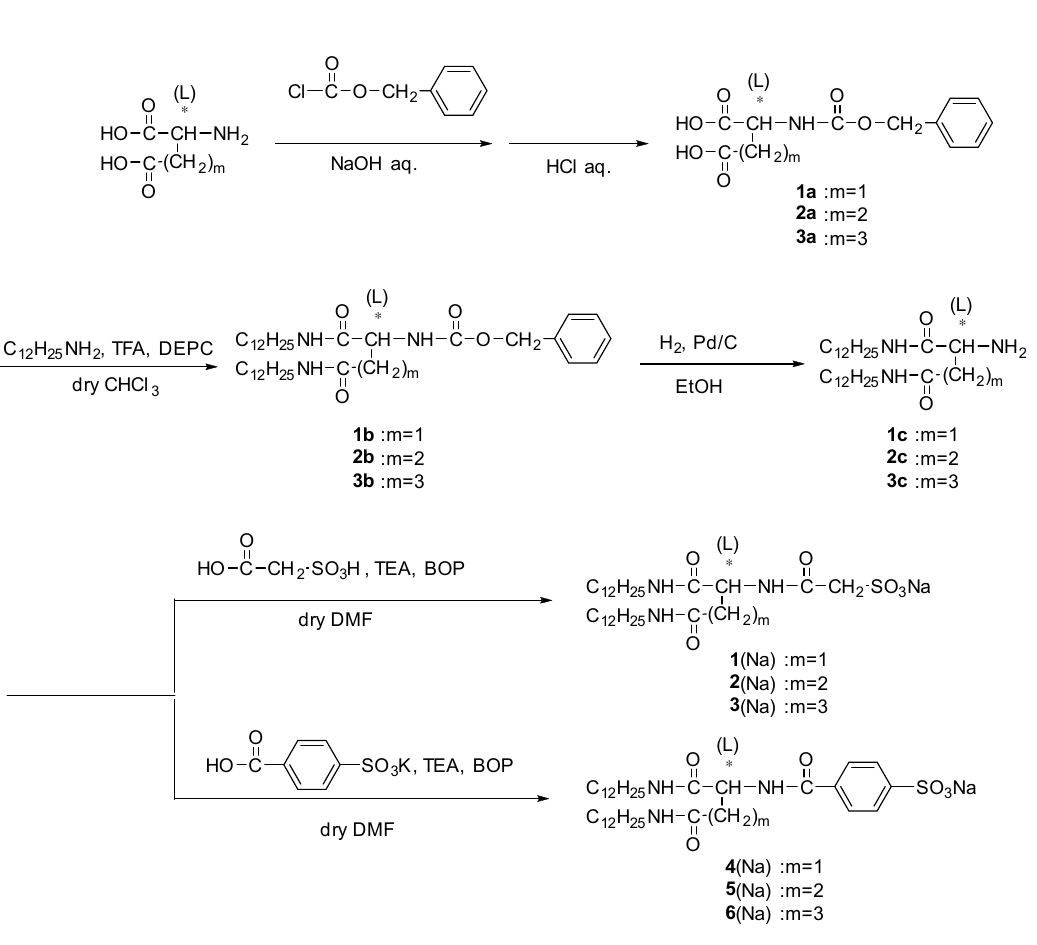
Figure 6. Synthesis of lipids 1 – 6 sodium salt.